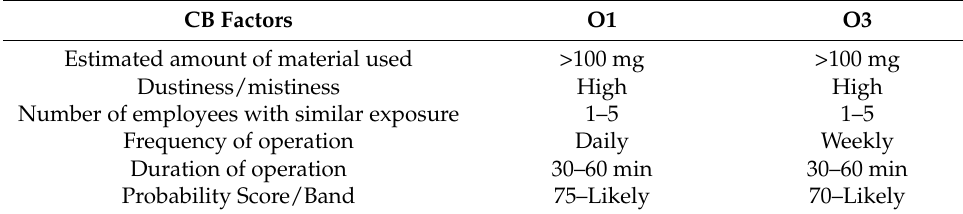
Table 9. Overall risk level without Controls of O1 and O3.